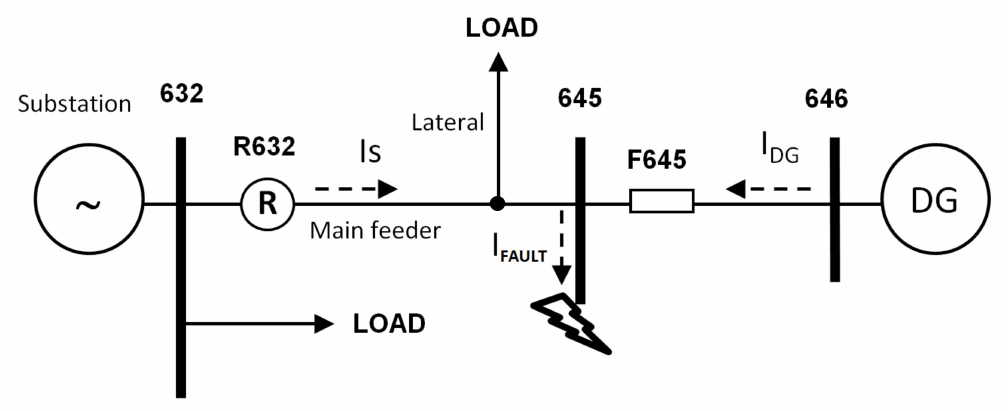
Figure 3. Protection Zone 1 electric circuit (see also Figure 2), in which a short-circuit in bus 645 is indicated. A three-phase short-circuit at bus 645 was simulated; the characteristic curves being plotted in Figure 4. In the graph, it shows that in the case of a fault between the substation and the DG, the presence of the latter represented a decrease in the value of the short-circuit current detected by the relay (R632 in Figure 3), from 536 A to 513 A. Thus, a loss in relay sensitivity (binding), as relay R632 at the main feeder detected a lower value of the fault current, with the triggering time also being delayed from 0.3 s to 0.35 s. These results are also summarized in Figure 5, and Table 2 at the end of this paper.